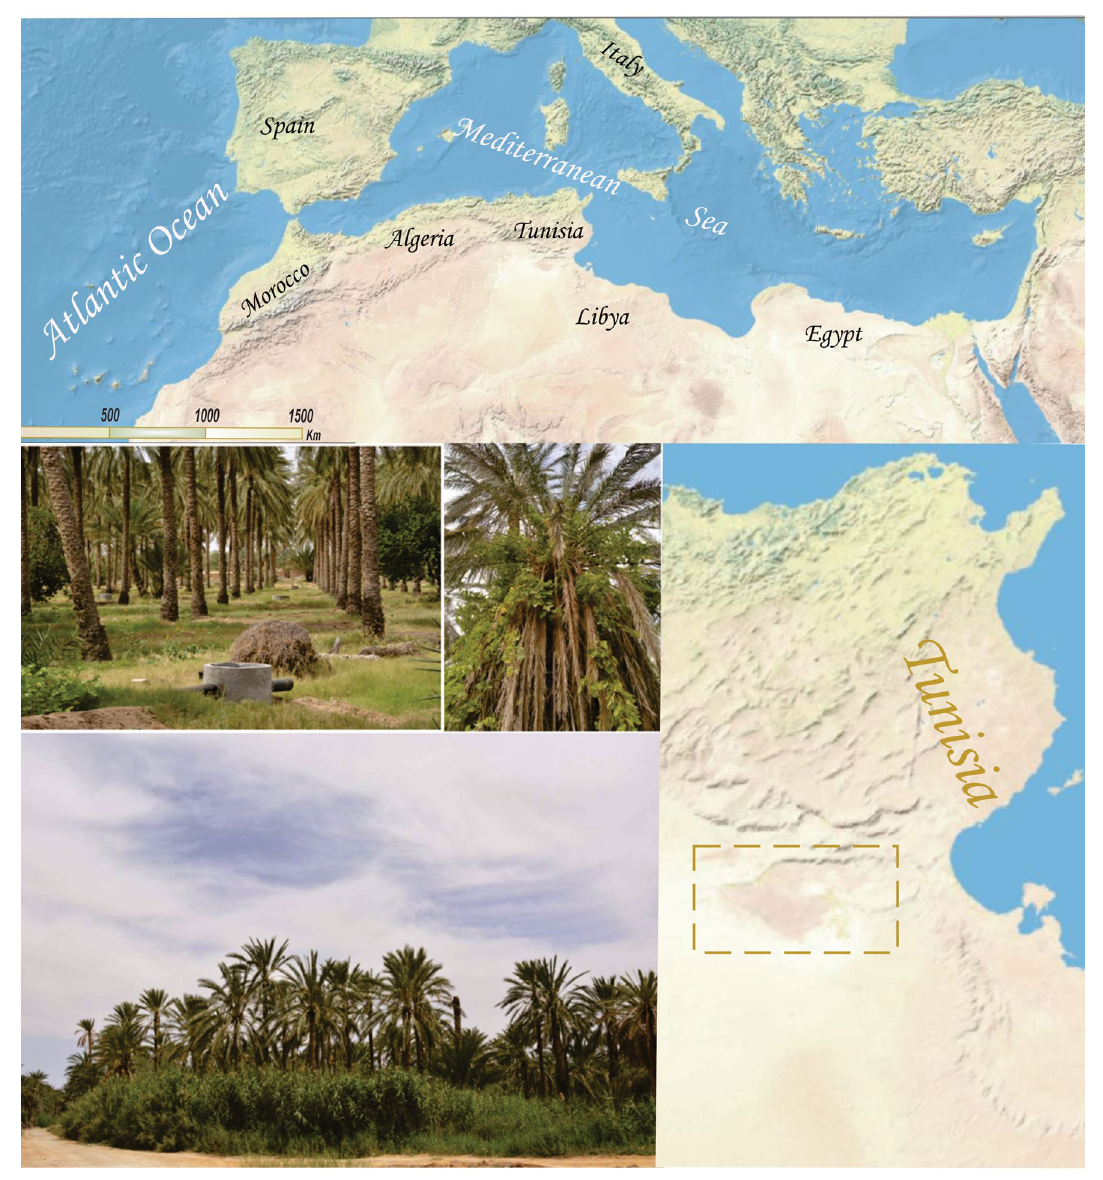
Fig. 1 Date agro-systems of the study